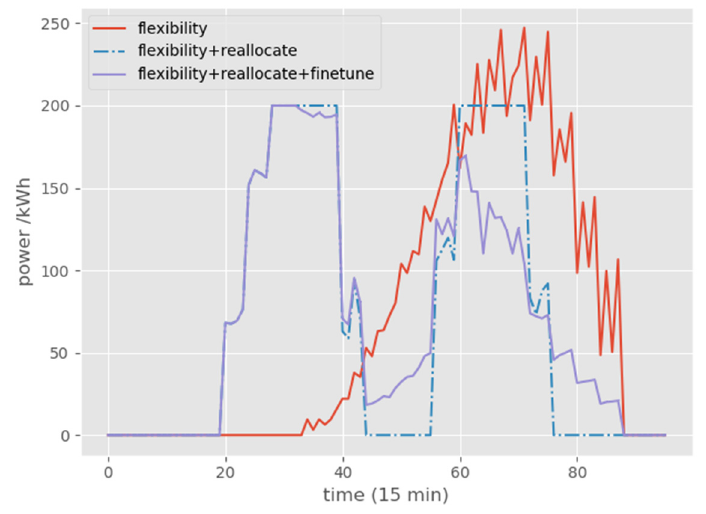
Figure 10. Total power distribution of the containers.